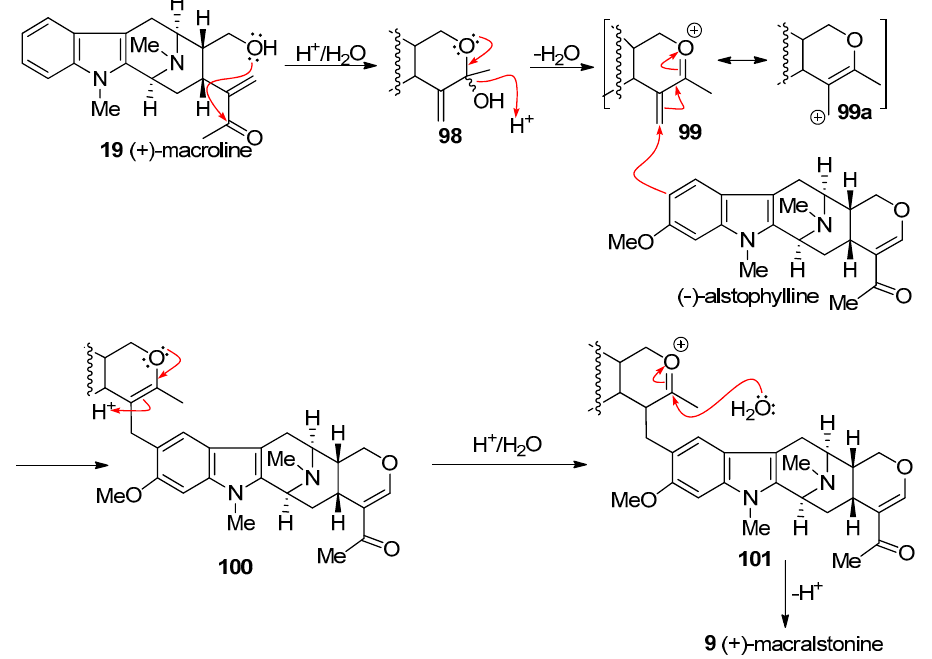
Figure 8. The possible alternative mechanism for the formation of (+)- 9 via a Friedel-Crafts alkylation process.